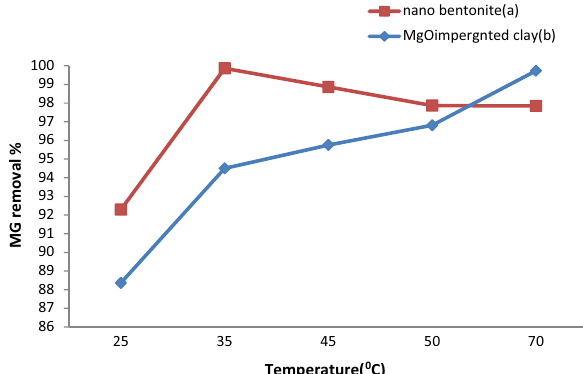
Figure 7. Effect of temperature on MG dye removal by ( a ) nano bentonite and ( b ) MgO impregnated